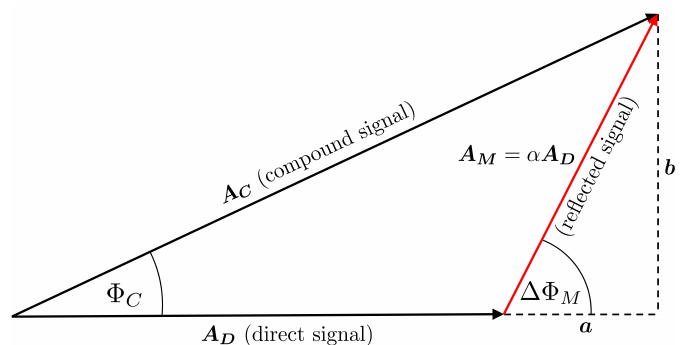
Figure 1. Resulting amplitude and phase error after superimposition of a direct signal and one reflected